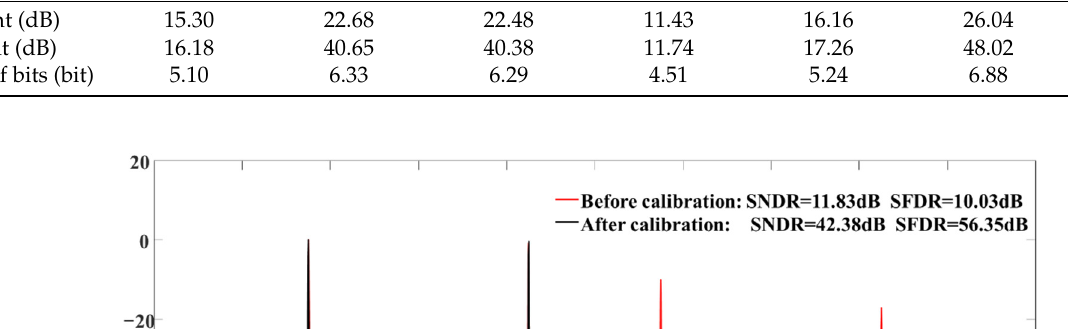
Table 6. Comparison of calibration effects in the ADC12DL3200EVM.